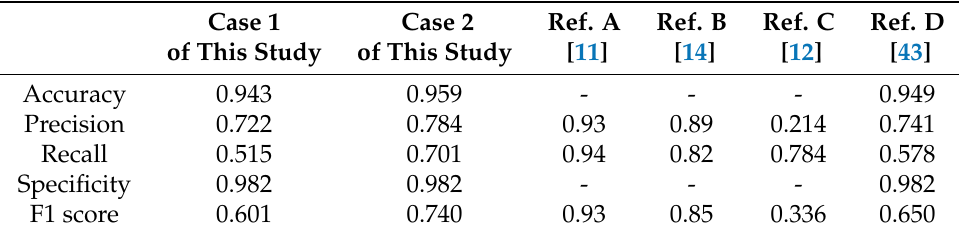
Table 6. Comparison of detection